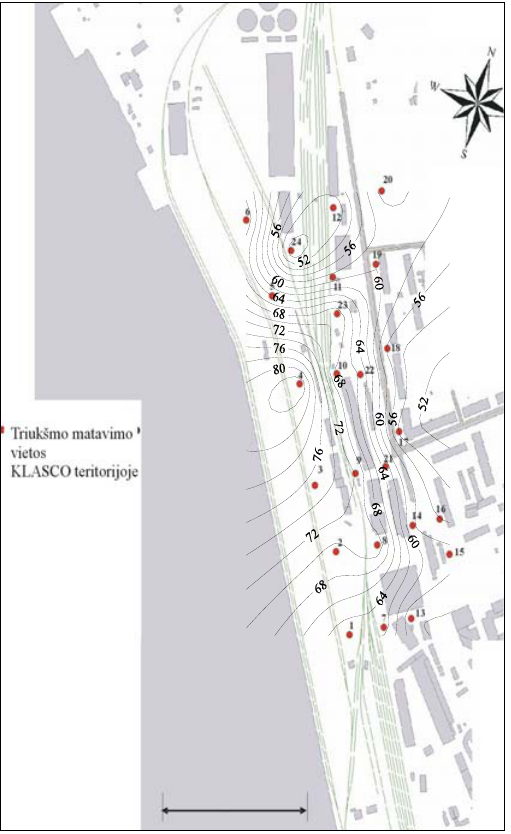
Fig 8. Dispersion of reciprocal noise level in the day in September